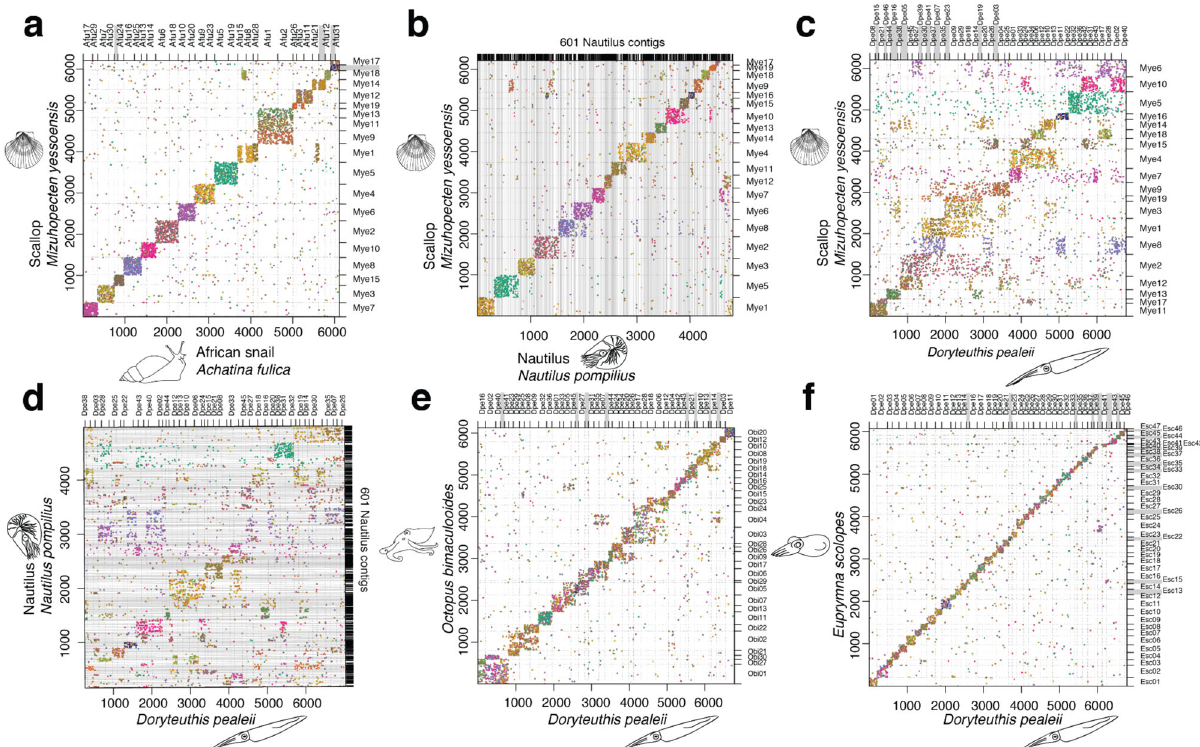
Fig. 2 Conserved synteny across coleoid cephalopods. Dotplots of orthologous gene content. a The scallop M. yessoensis and the African snail A. fulica . The chromosomes of these two molluscs are conserved both in regard to each other and to their linkage group identities. b M. yessoensis and N. pompilius , a non-coleoid cephalopod, show conservation of macrosynteny between early branching cephalopods and other molluscs. c M. yessoensis and D. pealeii illustrate derived rearrangements in squid genomes. d Comparisons of D. pealeii and N. pompilius suggest chromosomal rearrangements occurred after the split between nautiloids and coleoids. e D. pealeii and O. bimaculoides . Squid and octopus chromosomes show higher levels of conservation. f D. pealeii and E. scolopes . The chromosomes show near 1:1 correspondence between the two squid species. Axes are labeled with chromosome or contig IDs and gene